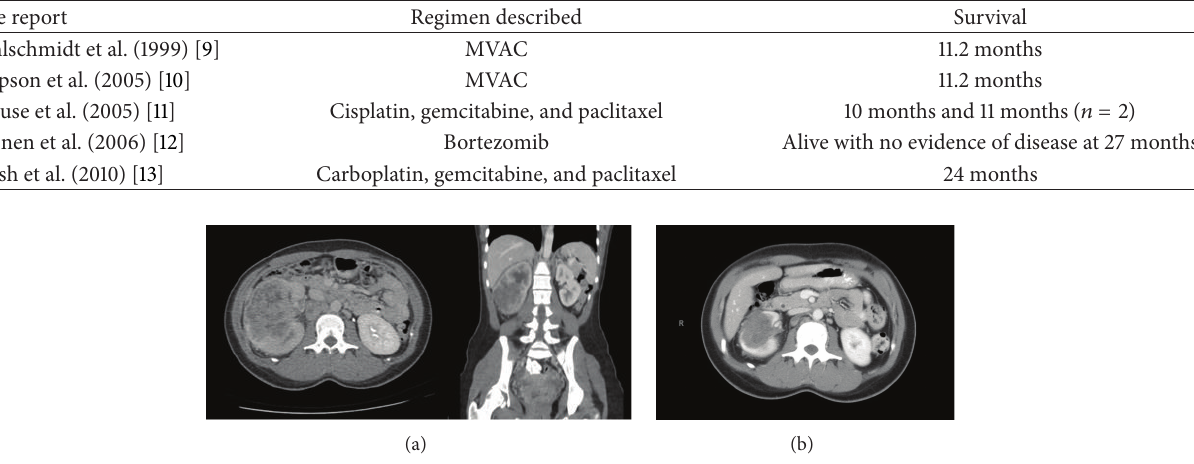
Figure 1: (a) CT scan of abdomen showing necrotic right-sided tumor replacing the kidney. (b) CT scan after chemotherapy.